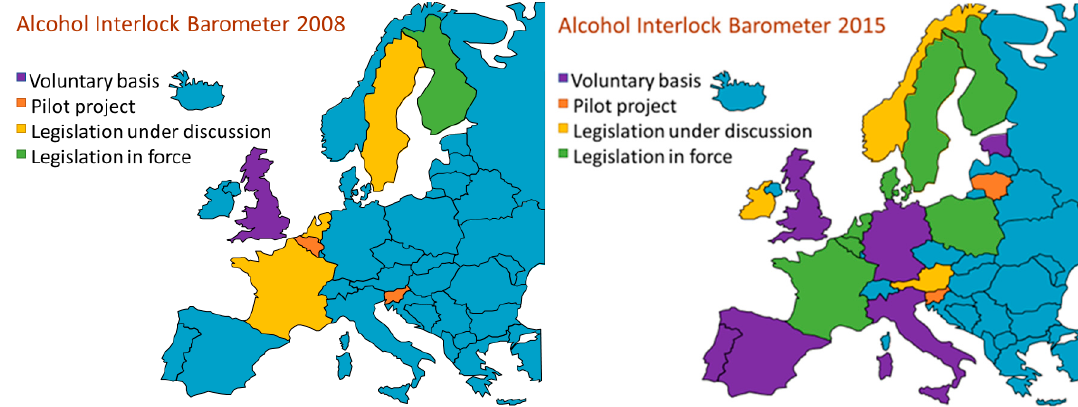
Figure 4. Reproduced with permission from the European Transport Safety Council. Extent of use of alcohol interlocks in European countries in 2008 and 2015 as reported to the ETSC at the time—colour blue indicates no use reported so far.